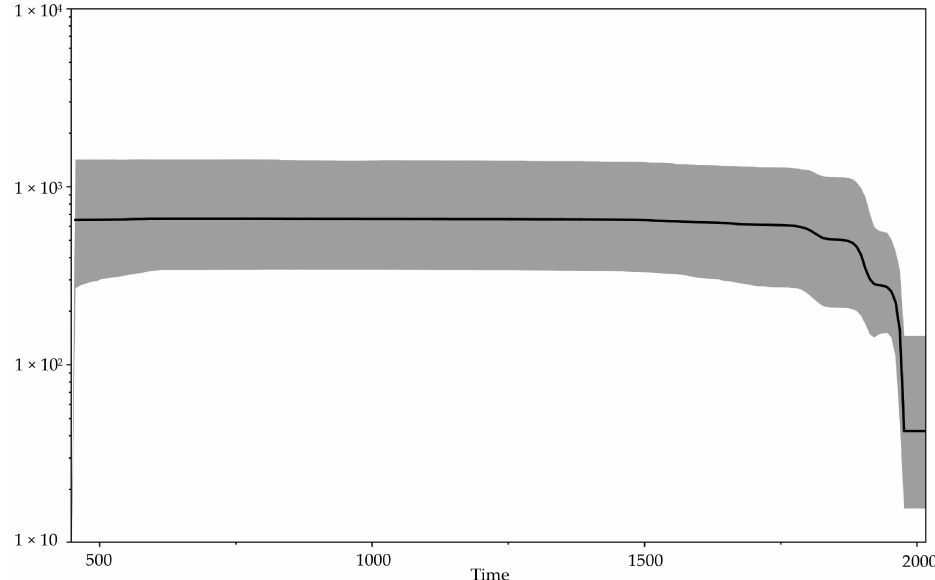
Figure 4. Bayesian skyline plot showing the demographic history of the orthopoxviruses . The x axis is in units of years, while the y axis represents effective population size. The black line represents the median value of the population size, and the 95% HPD (highest posterior density) is shown by gray